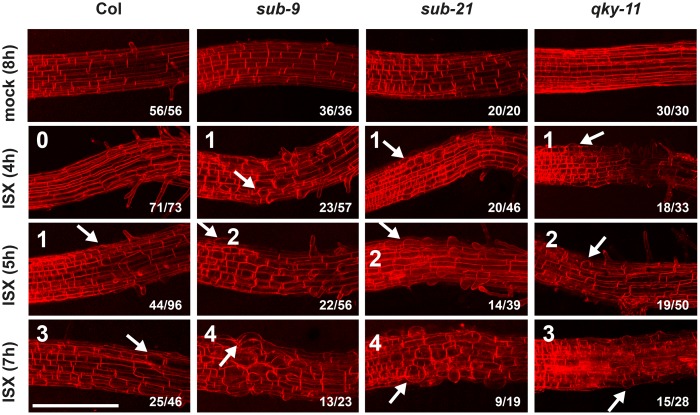
Root epidermal cell shape changes upon isoxaben treatment.Six-day-old seedlings counter-stained with the membrane stain FM4-64 are shown. Confocal micrographs depict the region where the elongation zone flanks the root meristem. Time of exposure in hours to 600 nM isoxaben (ISX) or mock is indicated as are the genotypes. Numbers of roots showing the phenotype are indicated (n/total number of roots scored). Arrows denote aberrant cell shapes. Scale bar: 0.1 mm.